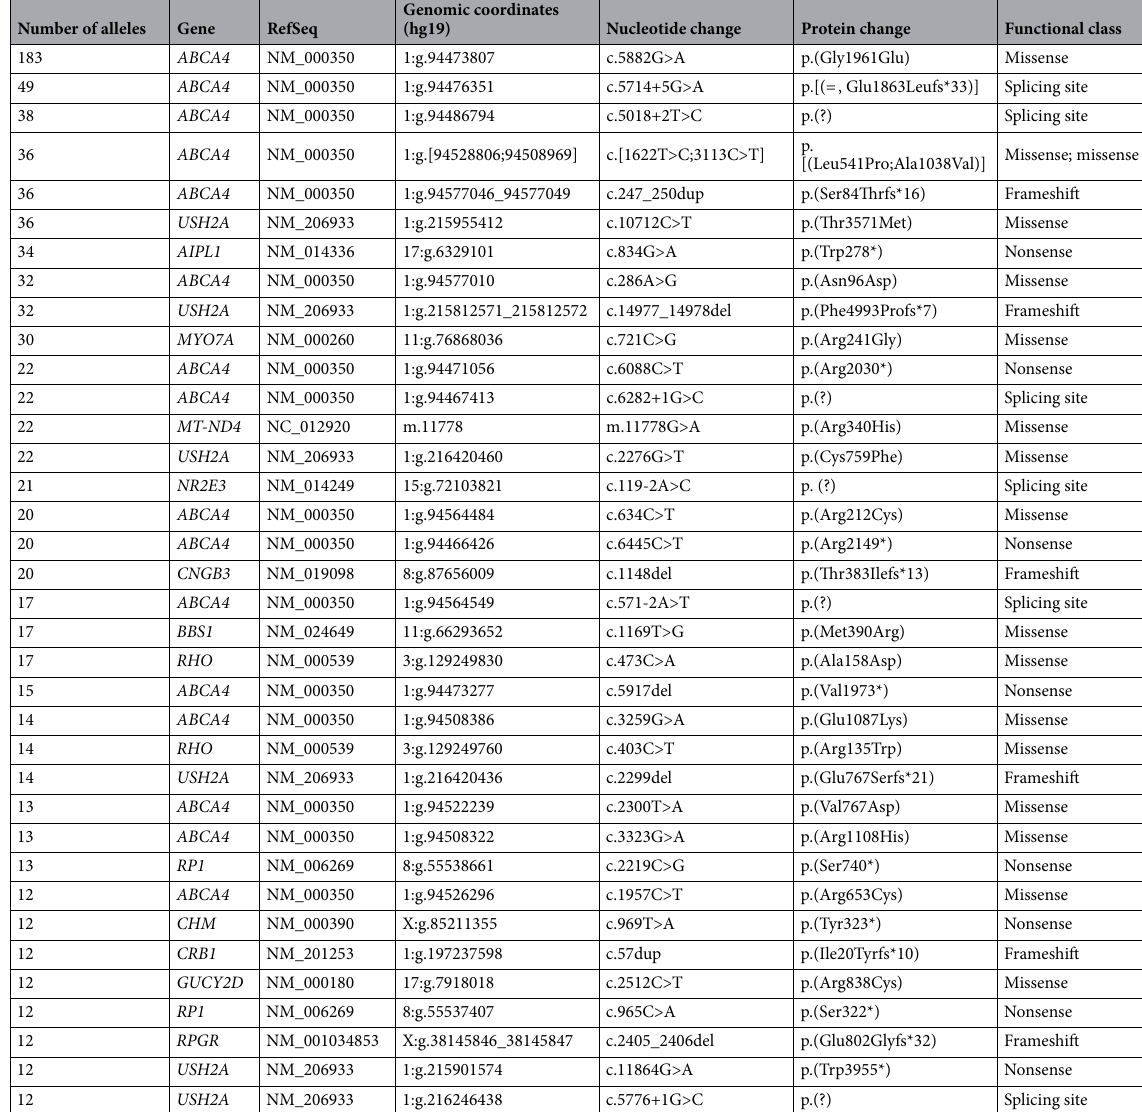
Table 4. Most frequent variants in the cohort (found on at least 12